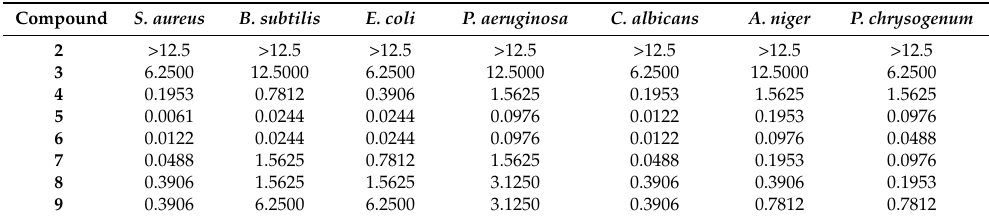
Table 4. Minimal inhibitory concentrations (MIC [mM]) of 1,4-bis-[ N -(1-alkyl)- N , N -dimethylammonium- methyl]benzene